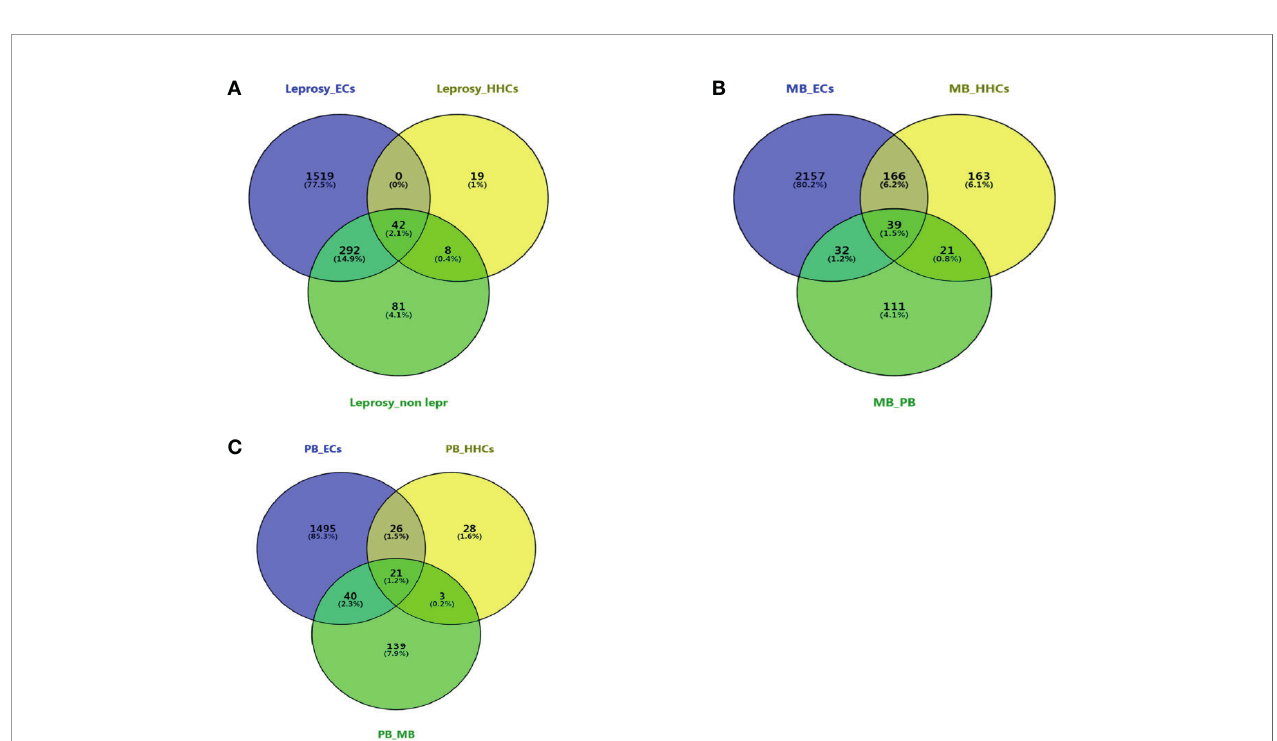
FIGURE 3 | Venn diagram of DEGs at different groups of leprosy patients and controls. Three-way Venn diagrams of genes signi fi cantly and differentially expressed in leprosy patients and non-leprosy controls. (A) Venn diagram of DEGs between leprosy patients and ECs, HHCs, and non-leprosy controls. (B) Venn diagram of DEGs between MB leprosy patients and ECs, HHCs, and PB leprosy patients. (C) Venn diagram of DEGs between PB leprosy patients and ECs, HHCs, and MB leprosy patients. MB, multibacillary; PB, paucibacillary; HHCs, healthy house contacts; ECs, endemic controls; DEG, differentially expressed gene.